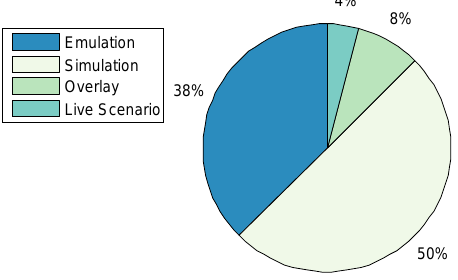
Figure 7. Cyber-Range Methods of